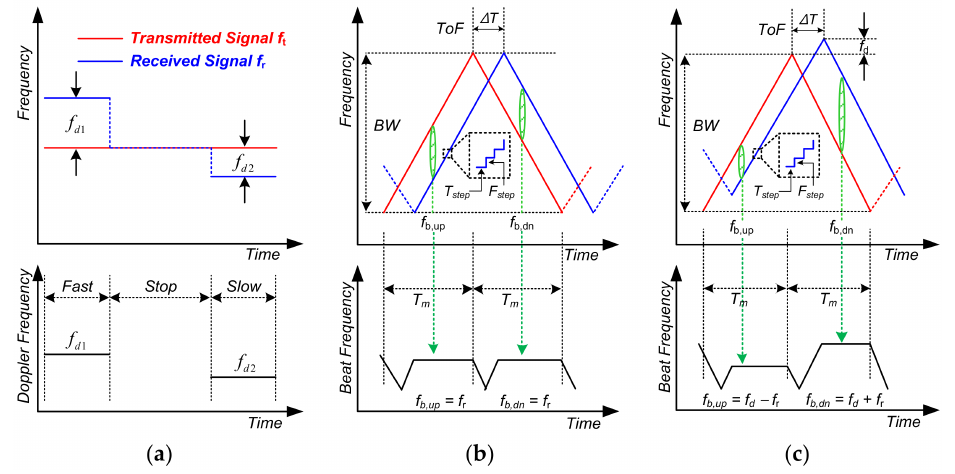
Figure 3. Plots of the operation method of CW radar ( a ) Doppler mode operation. As an example of FMCW mode operation, triangular waveform is described when the target is ( b ) stationary and ( c ) moving condition.